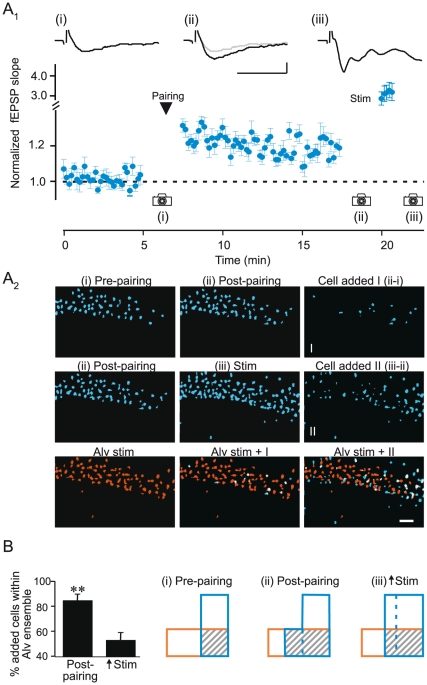
Pairing-induced synaptic plasticity selectively recruits cells from a defined population.A1, Summary plot showing increases in fEPSPs following pairing-induced LTP and subsequent increase in SC stimulus strength (n = 6). Example fEPSPs (top traces) from one experiment at the indicated time points (scale bars, 0.2 mV, 20 ms). A2, Cell activity maps from one experiment at the indicated time points (cameras, scale = 50 µm). Top row, Images show cells activated by the SC stimulation (blue) before (i) and after (i) pairing along with the new cells recruited (Cells added 1). Middle row, Cells activated following pairing (ii) and after increasing stimulus strength (iii) along with new cells recruited by the stimulus increase (Cells added II). Bottom row, images show cells activated by the alveus stimulation (orange) superimposed with those of the SC ensembles recruited by pairing-induced plasticity (Alv stim + I) and the increase in stimulus strength (Alv stim + II). Cells color-coded white belong to both the SC and alveus ensembles. B, Left, Summary showing that a larger fraction of newly added cells belong to the alveus population following LTP induction compared to those recruited by increased stimulation strength (n = 6; **, p<0.01). Right, diagram illustrating the dynamics of neuronal ensembles in this experiment. Blue and orange outlines represent the neuronal populations activated by SC and alveus stimulation, respectively. Hatched areas indicate cells that belong to both ensembles.